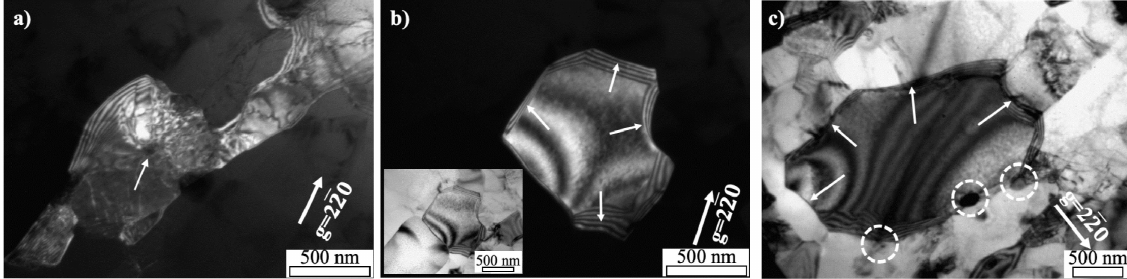
Figure 14. Evolution microstructure of AM9 annealed at 300 ◦ C for ( a , b ) 5 s and ( c ) 60